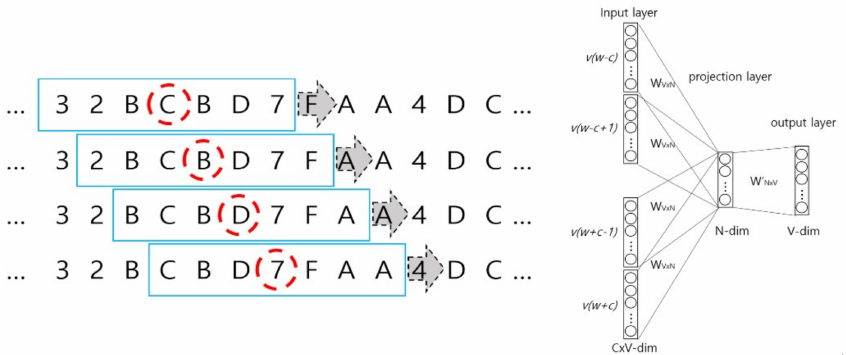
Figure 5. Shifting windows on the sequence of symbolized EEG signal for continuous bag of words (CBOW) feeding ( left ) and CBOW architecture ( right